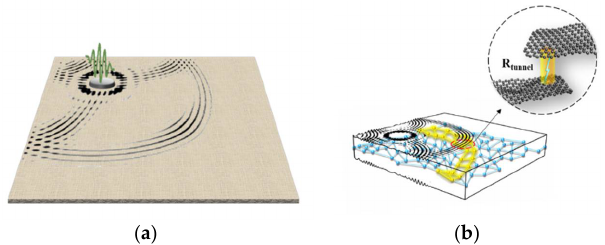
Figure 2. Concept of self-sensing UGWs: ( a ) UGWs, excited by a PZT wafer, propagating in a